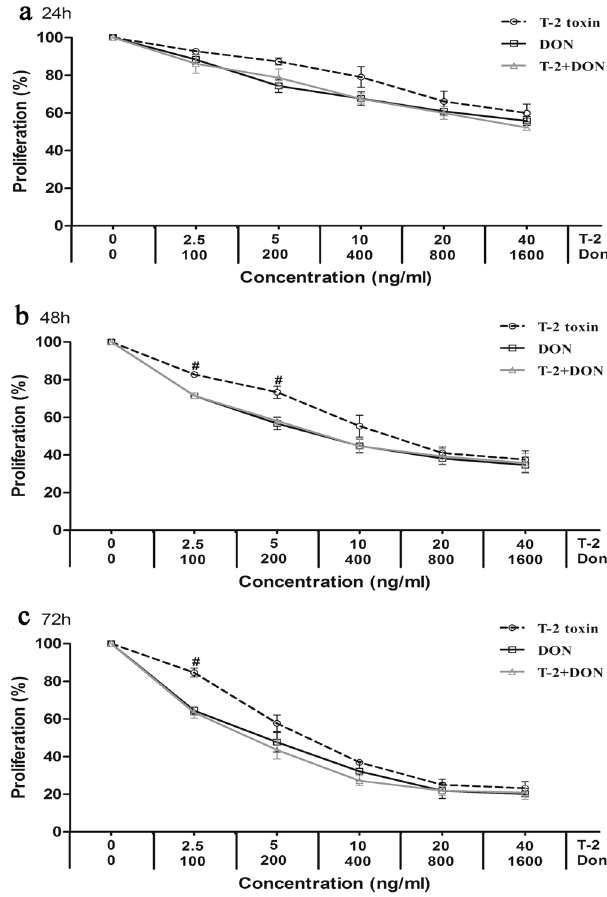
Figure 3. Cytotoxicity of T-2 toxin and/or DON in the kidney-derived cell line, HK-2. Cells were exposed to mycotoxins for ( a ) 24 h, ( b ) 48 h and ( c ) 72 h and analyzed by the MTT method, as described in Fig. 1. Each data point represents the mean ± SEM from three independent experiments with replicate samples, * p < 0.05 indicates significant differences between the mixture and T-2 toxin alone, # p < 0.05 represents significant differences between the mixture and DON alone.